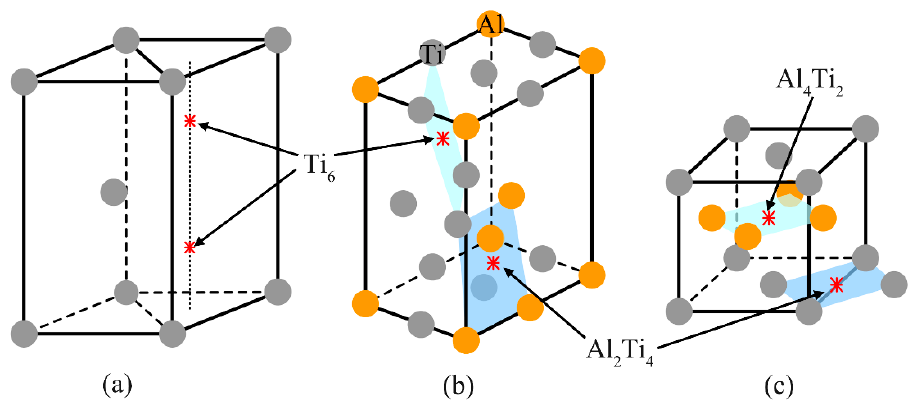
Figure 5. Octahedral interstitial sites for oxygen atoms in the lattices of the ( a ) α , ( b ) α 2 and ( c ) γ